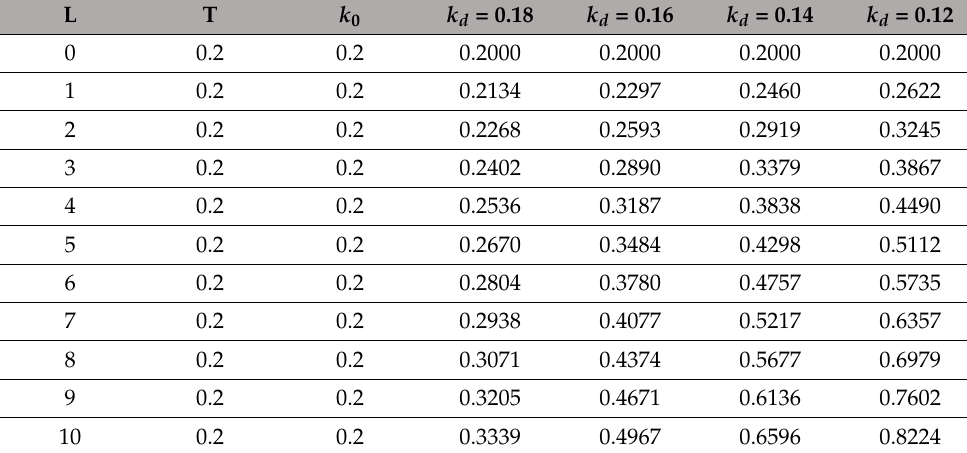
Table A11. Dependence of the equity cost, k e , on leverage level L at p = 4 and at different k d = 0.18;